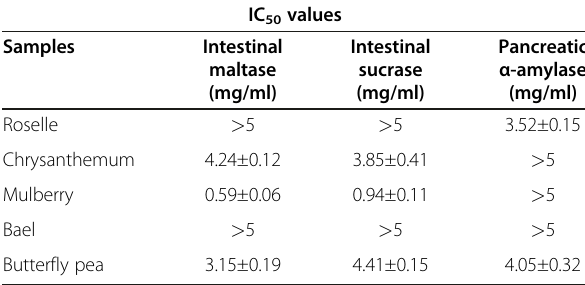
Table 3 The IC 50 values of plant-based foods against intestinal glucosidase (maltase and sucrase),